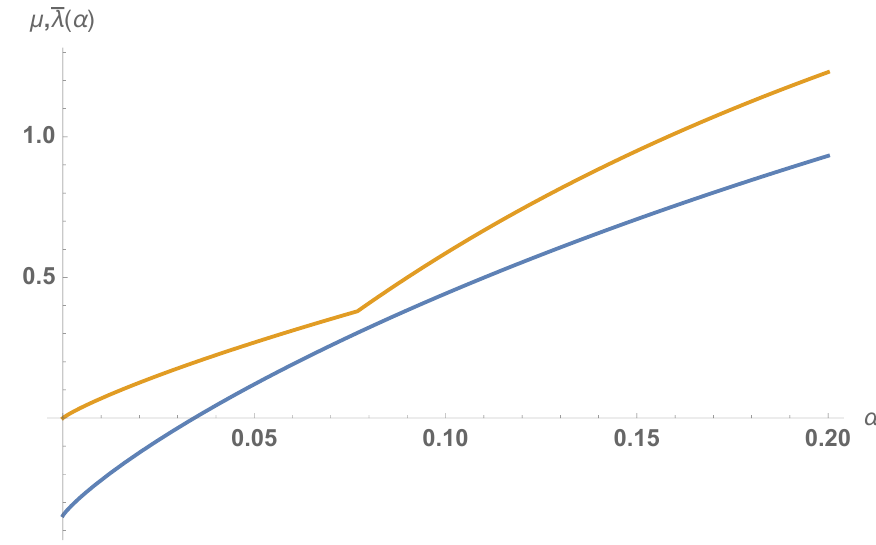
Figure 5 . Leading (exponential) contribution to the square root of the variance of the density of states (blue line) vs. mean density of states (orange